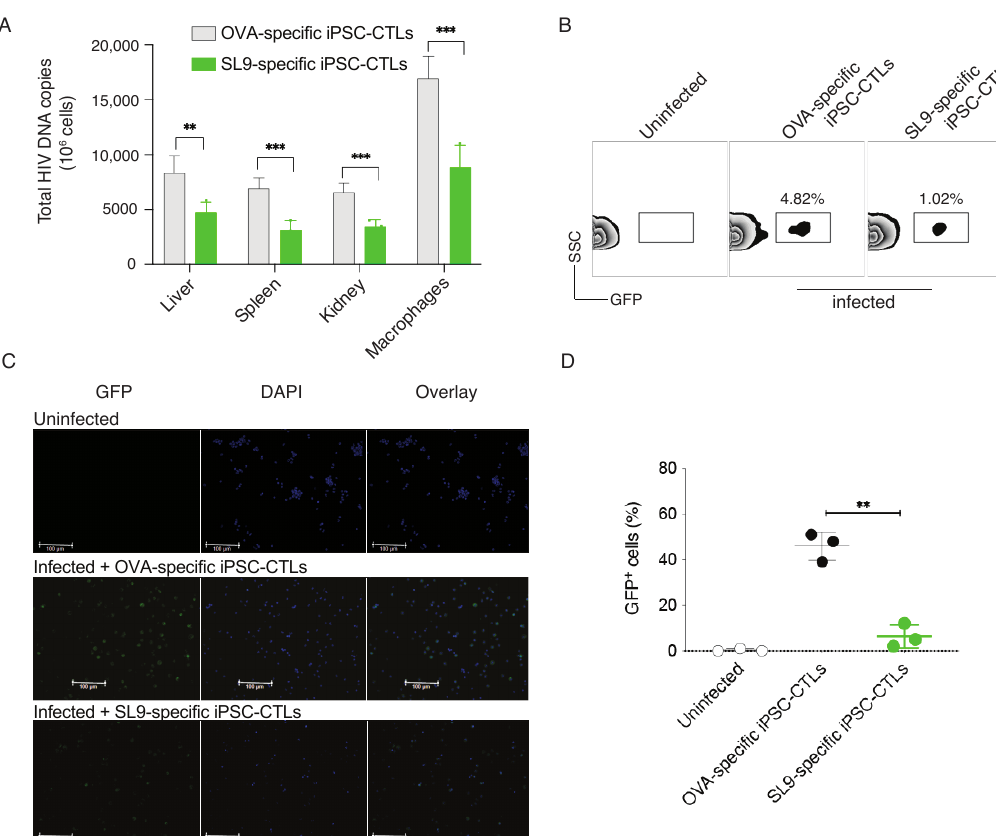
Figure 5. Adoptive transfer of SL9-specific iPSC-CTLs suppress EcoHIV replication. HHD mice were i.v. adoptively transferred with SL9 or OVA 257–264 -specific DsRed + CD8 + pre-iPSC-CTLs and in the following week were i.p. infected with EcoHIV. Three weeks after EcoHIV infection, EcoHIV replication was analyzed. ( A ) qPCR. DNA from mouse spleen, liver, kidney tissues and peritoneal macrophages was analyzed for viral replication by qPCR. ( B ) EcoHIV replication was moni- tored by GFP expression in the spleens by flow cytometry. ( C ) EcoHIV GFP + cells were examined by immunohistochemistry staining of spleens. Data are representative of five mice per group of three independent experiments. ( D ) Quantification of GFP + T cells. The values represent mean ± S.E.M. (** p < 0.01, *** p < 0.001, Unpaired t